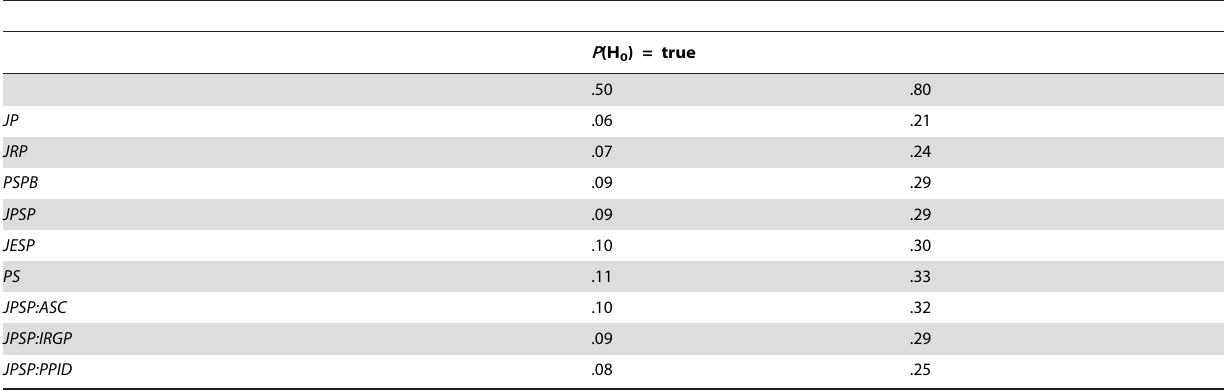
Table 5. Estimated False Positive Rates of Findings Published across Journals, Assuming no Questionable Research